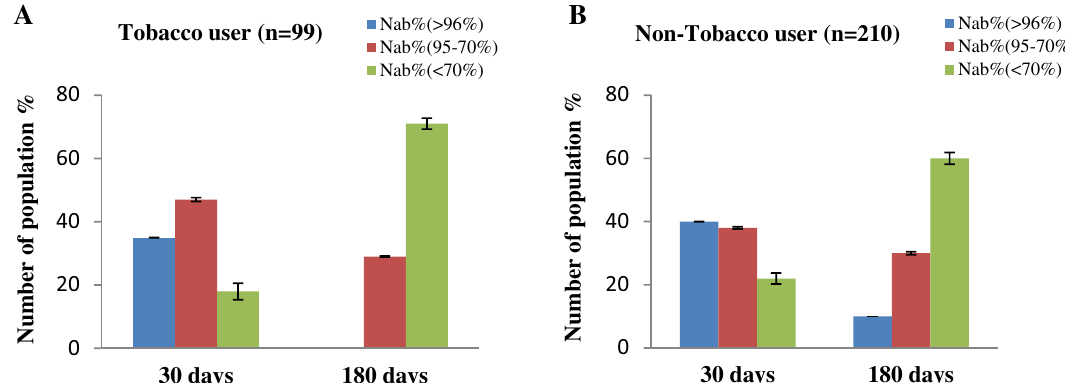
Figure 4. Percentage (%) people with immune response regarding ( A ) Tobacco user and ( B ) non-Tobacco user group (only considered male in our country’s context, females barely smoke in Bangladesh n = 309) after 30 days and 180 days of completing 2nd immunization.